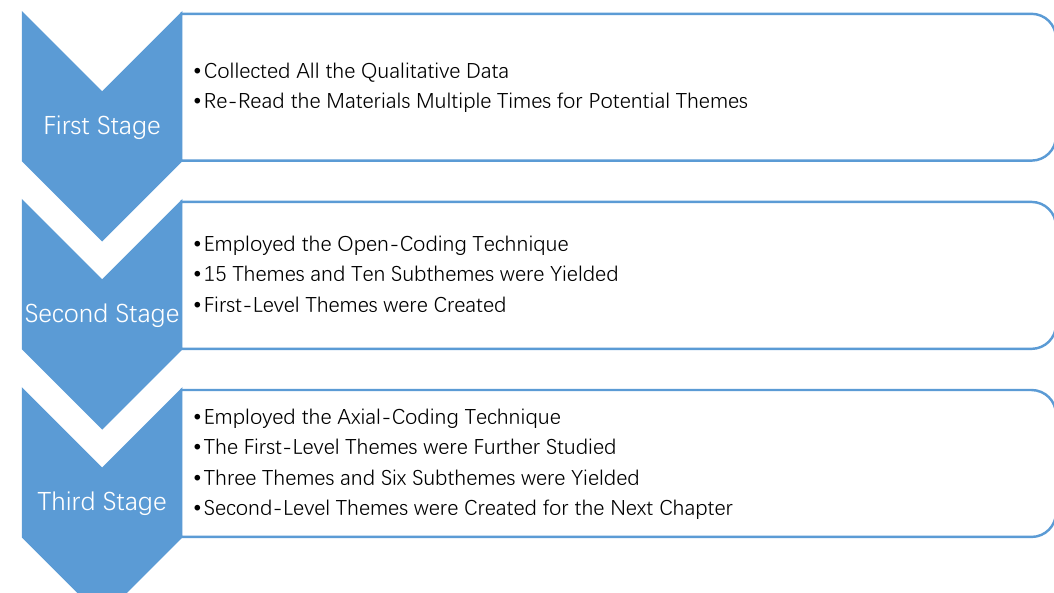
Fig. 1. Data Analysis